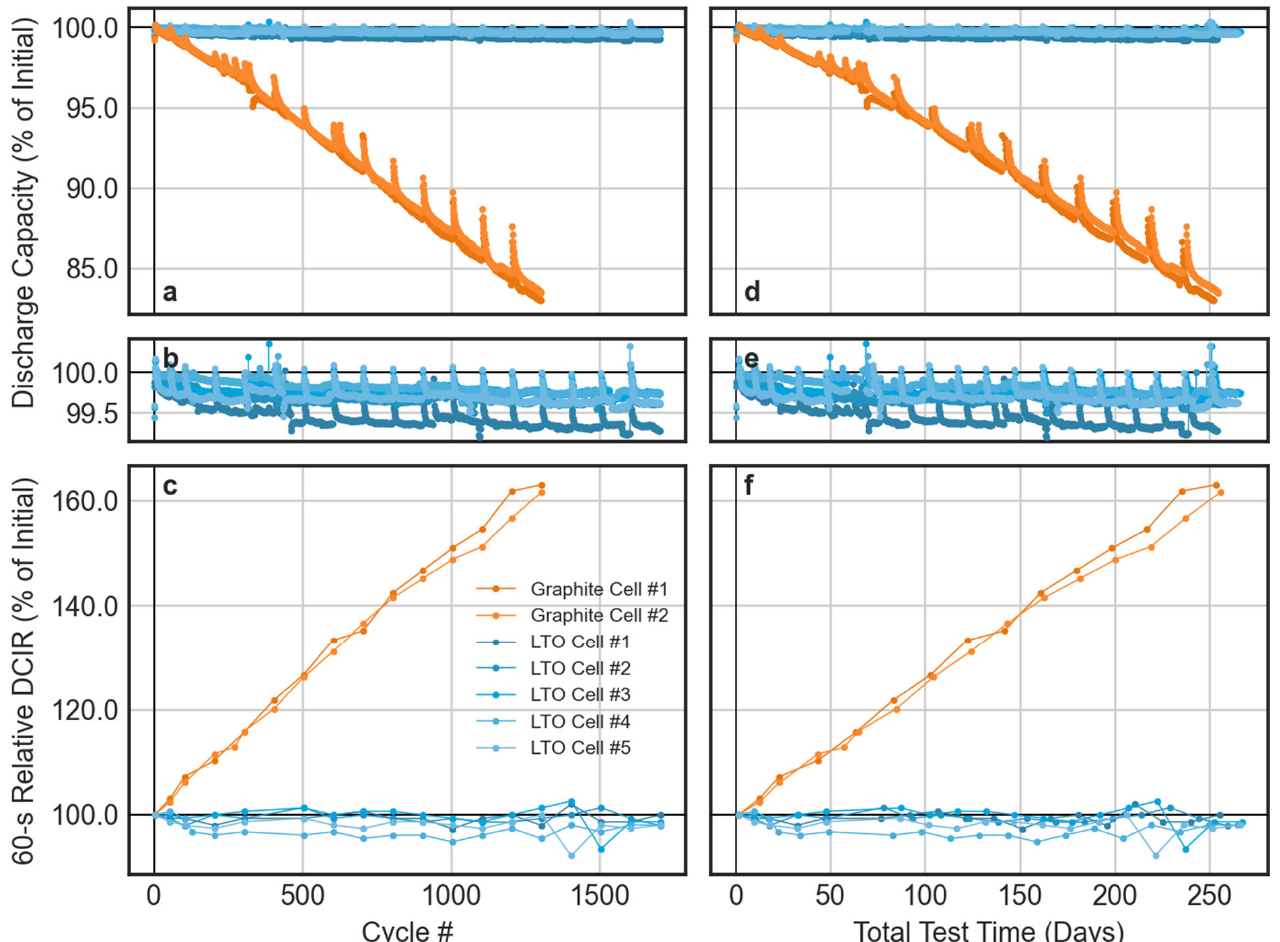
Figure 1. The left ‐ hand column shows the standard cycle discharge capacity ( a,b ) and DC internal resistance (DCIR) at 50% depth-of-discharge (DoD) ( c ), vs. the number of cycles for baseline cells. The right-hand column ( d – f ) shows the same metrics presented against total active testing time. All cycles were performed at 37 ± 1 ◦ C. Orange colors indicate graphite cells; blue colors indicate lithium titanium oxide (LTO) cells.